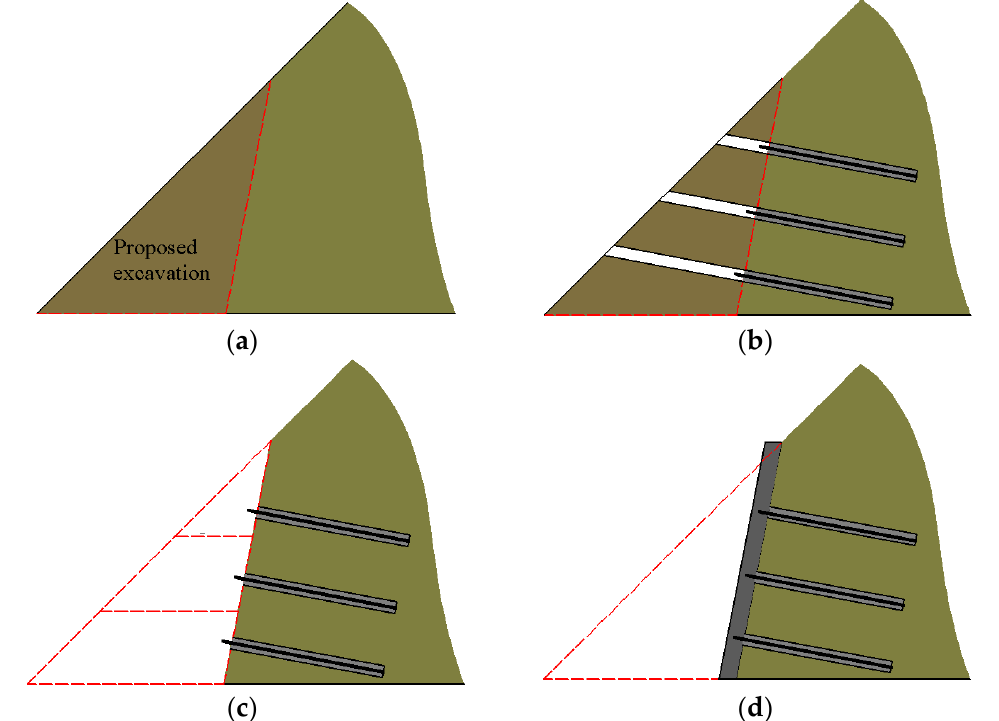
Figure 3. Construction procedures for the lattice beam with pre-set anchors. ( a ) Determining the proposed excavation. ( b ) Drilling holes and installing anchors. ( c ) Cutting slope from top to bottom by layer. ( d ) Installation of lattice beam.